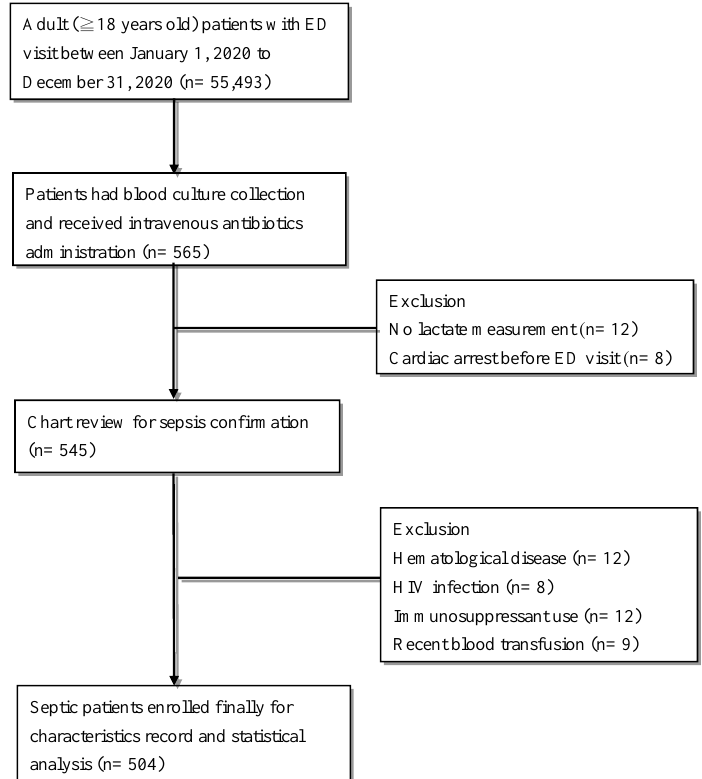
Figure 1. Flowchart of patient